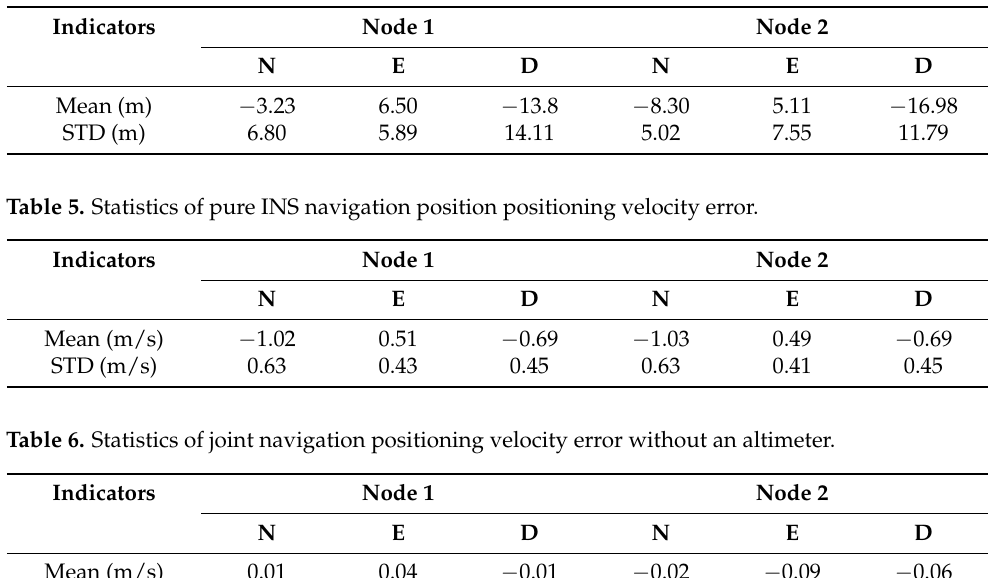
Table 4. Statistics of joint navigation and positioning position error without an altimeter.